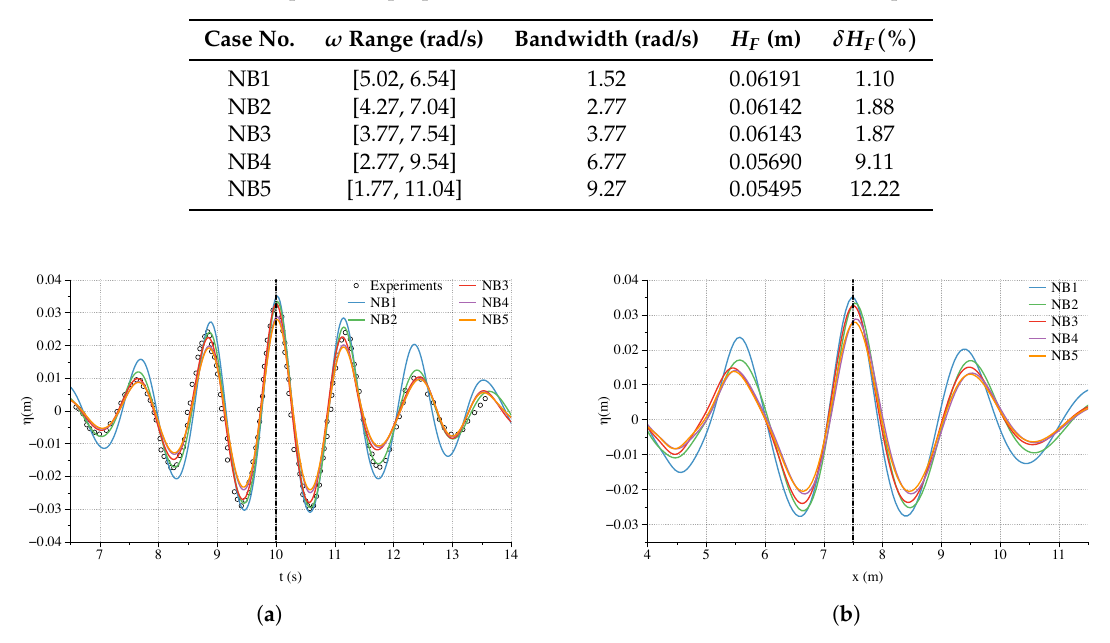
Figure 21. Comparison of the wave surface elevations with five different frequency bandwidths. ( a ) the time series at the designated focusing location x = 7.5 m, ( b ) the spatial wave profile in the longitudinal direction at the designated focusing time t = 10